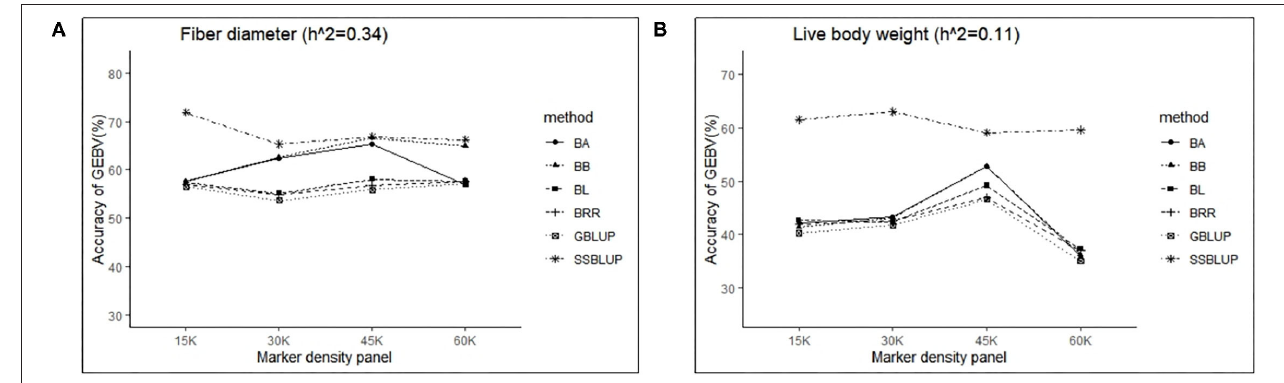
FIGURE 2 | The change trends of accuracy of GEBV with increasing marker density panel with GBLUP and Bayes method.